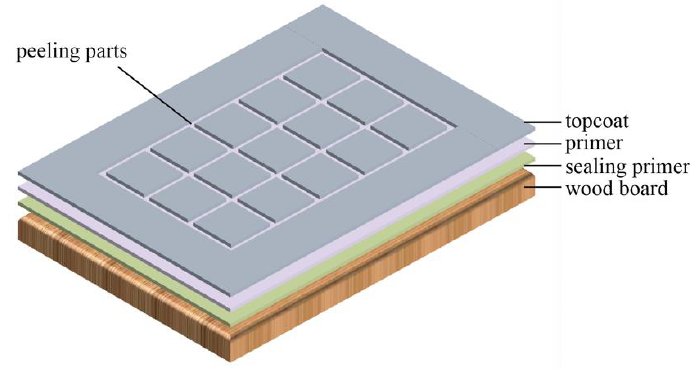
Figure 2. Coating structure and adhesion test method.